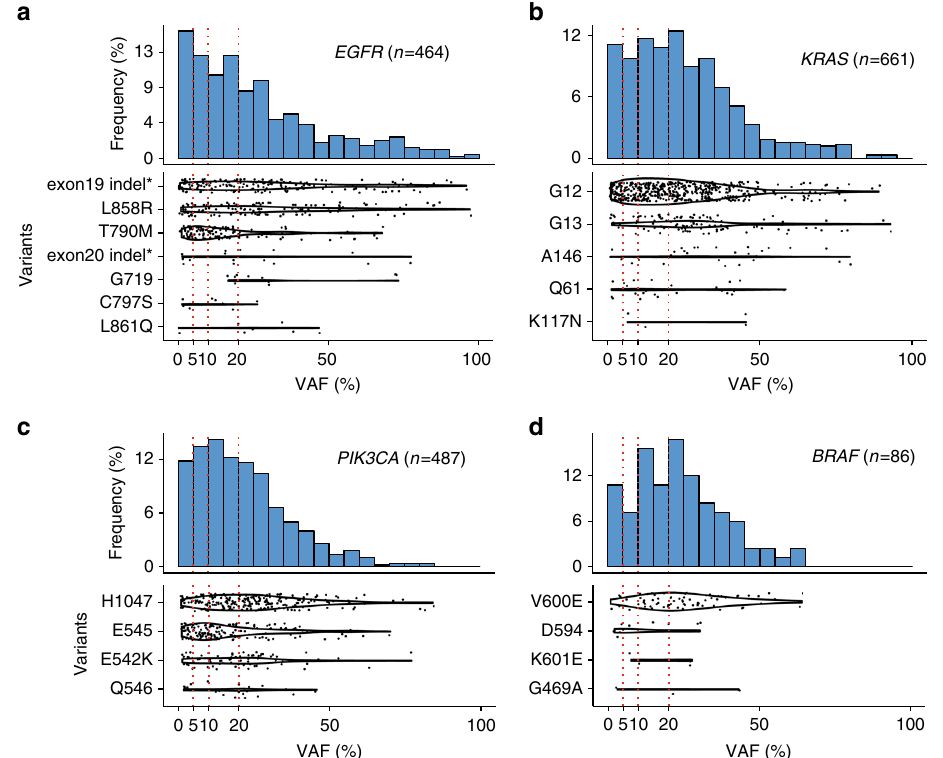
Fig. 1 Prevalence of point mutations with low variant allele fraction (VAF) in cancer specimens. VAF distributions of the four most frequently mutated actionable genes in our data: EGFR , KRAS , PIK3CA , and BRAF . Each dot corresponds to a sample, with the violin plot showing the estimated density; the red vertical dotted lines are at 5, 10, and 20% VAF. 24% of the EGFR T790M, 17% of PIK3CA E545, and 12% of KRAS G12 mutations are below 5%. Two important non-frameshift indels (indicated by asterisk) are also included for